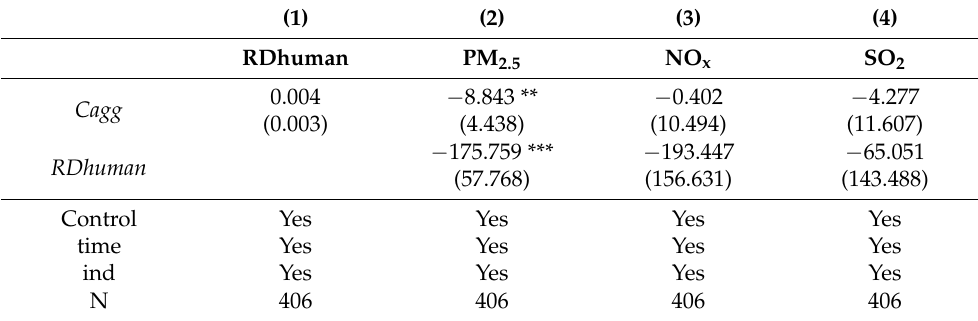
Table 17. Test of the mediating role of human capital in